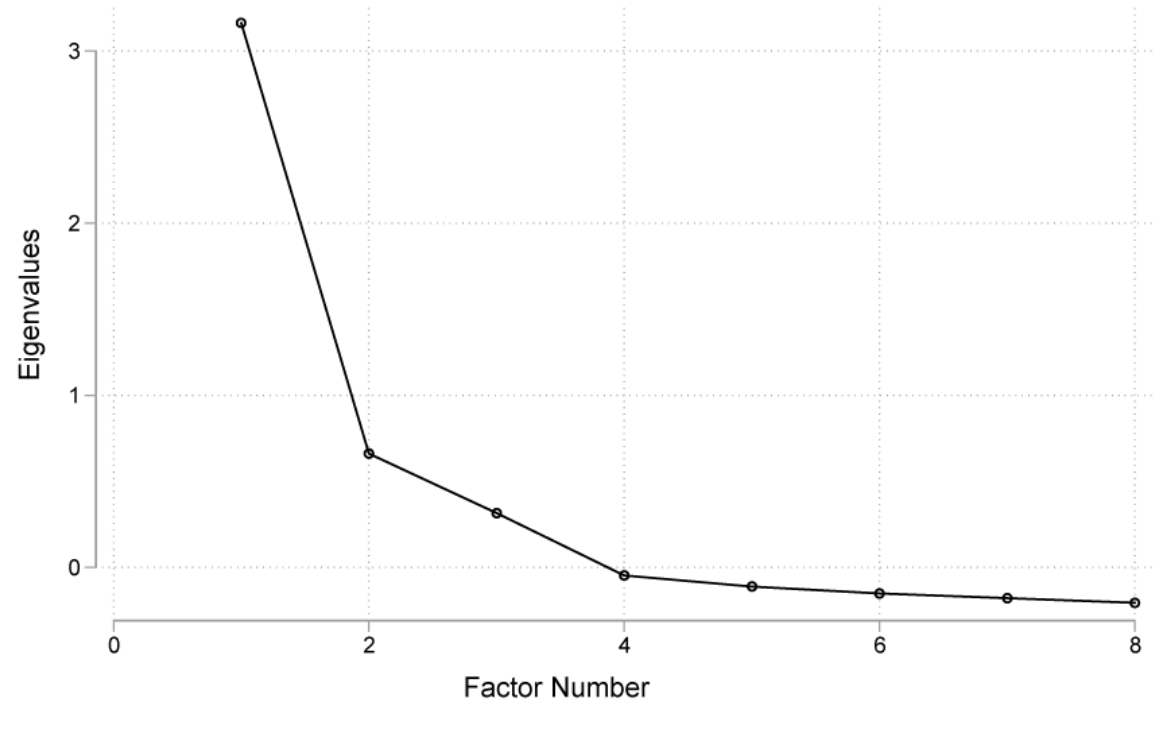
Figure 1. Scree plot for Chinese version of the eHealth Literacy